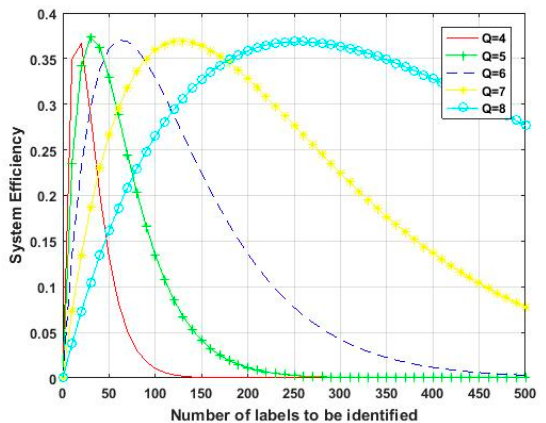
Figure 14. System e ffi ciency for di ff erent Q values. Figure 14. System efficiency for different Q